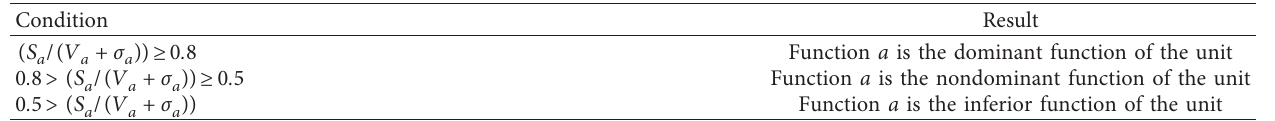
Table 2: Evaluation index system for rural multifunction.